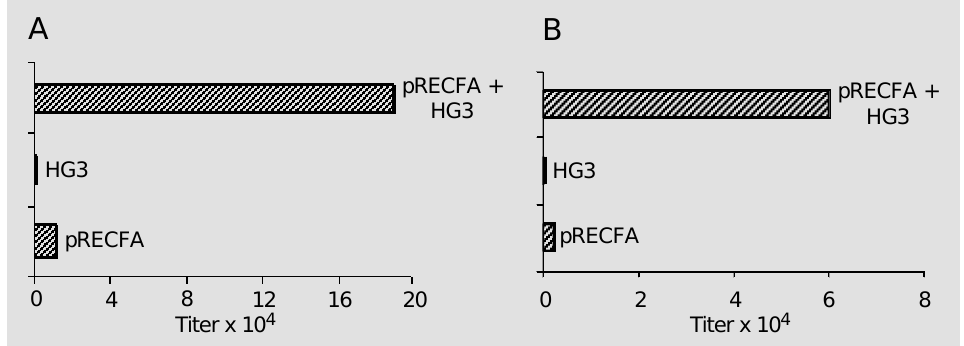
Figure 1 - Systemic IgG CFA/I- specific antibody response in mice immunized im with pRECFA as primer and orally boosted with two doses of Sal- monella vaccine strain (HG3). The doses of Salmonella vaccine were given two weeks (A) or 54 weeks (B) after the last DNA dose. Mice were immunized with the complete protocol (pRECFA + HG3), two pRECFA doses (pRECFA) or two HG3 doses. Column length indicates the mean titers of pooled serum samples (N = 5). Standard devia- tions were less than 5% of the calculated mean